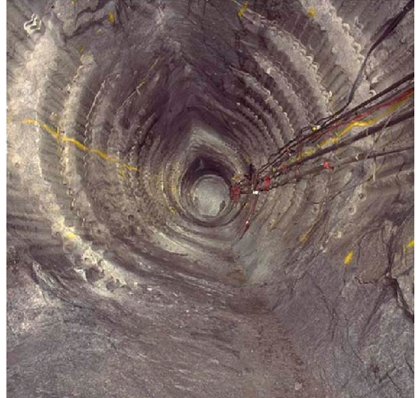
Figure 4. Damage profile of a tunnel excavated at depth 420 m within massive hard rock in Canada [35].